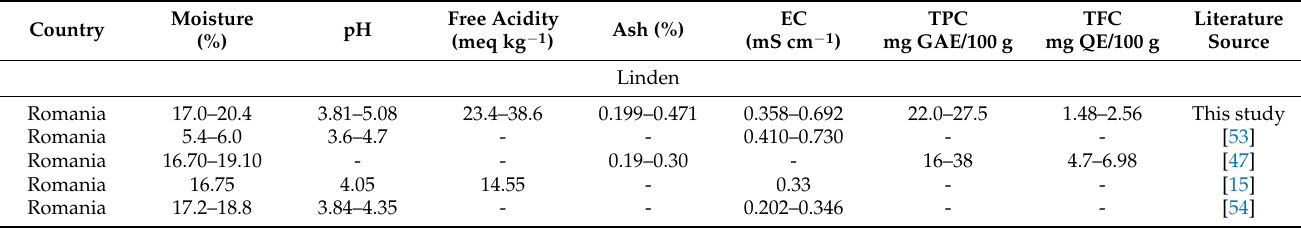
Table 10. Comparative physicochemical properties of seven types of monofloral